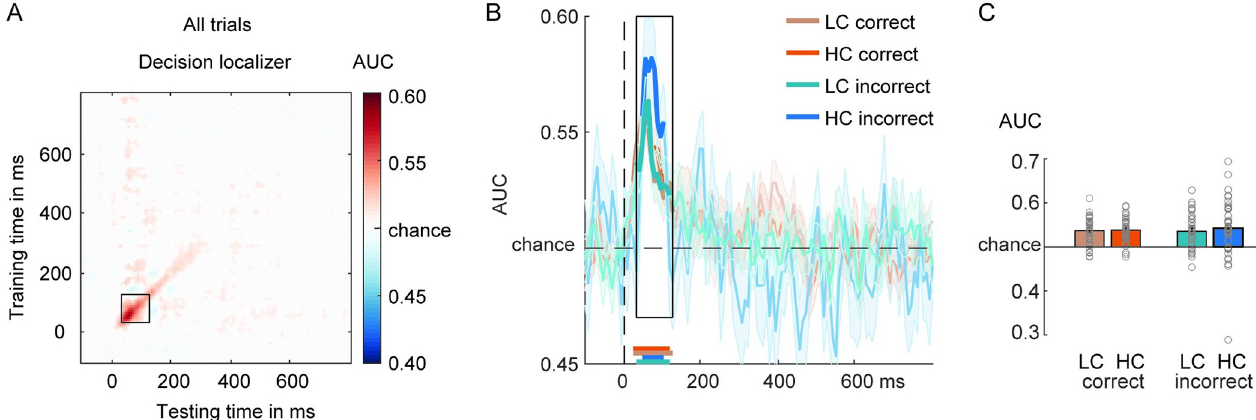
Fig 5. Tilt (right/left) classification based on decision localizer. ( A ) GAT matrix of the decision localizer data for arbitrating left/right tilted stimuli (irrespective of face/house category, based on occipital–parietal channels). The black square-shaped inset indicates the time-window used for averaging AUC decoding scores (30–130 ms). ( B ) On-diagonal time courses for correct and incorrect decisions separated by confidence. Colored horizontal lines indicate periods of significant decoding with respect to chance. Classification performance was evaluated at each time point using cluster-based permutation testing (two-tailed cluster-permutation, alpha p < 0.05, cluster alpha p < 0.05, N permutations = 1,000). ( C ) Bar plots show average AUC values for the time-window of interest highlighted in panels (A) and (B). The underlying data and scripts supporting this figure can be found on FigShare (https://doi.org/10.21942/uva.c. 6265233.v1). AUC, area under the curve; GAT, generalization across time; HC, high confidence; LC, low